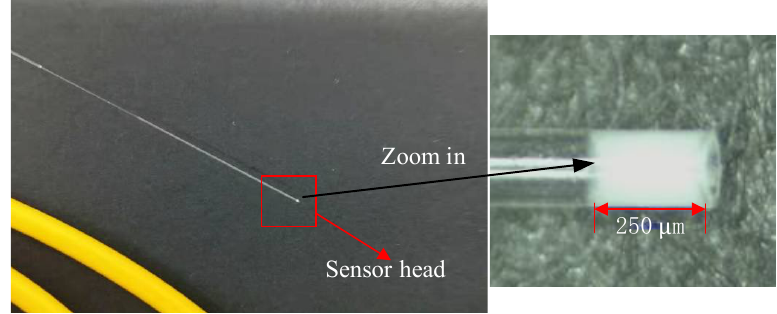
Figure 12. A pressure sensor sample. Four pressure sensors with different curvature radii of spherical end faces were fab- ricated, and their interference spectra are given in Figure 13. As the curvature radius increases, the fringe contrast indeed increases. The signal-to-noise ratio is greatly improved because the noise levels progressively decrease. When the curvature radius of the spherical end face is 90 µ m, the fringe contrast is around 20 dB. Results are consistent with the